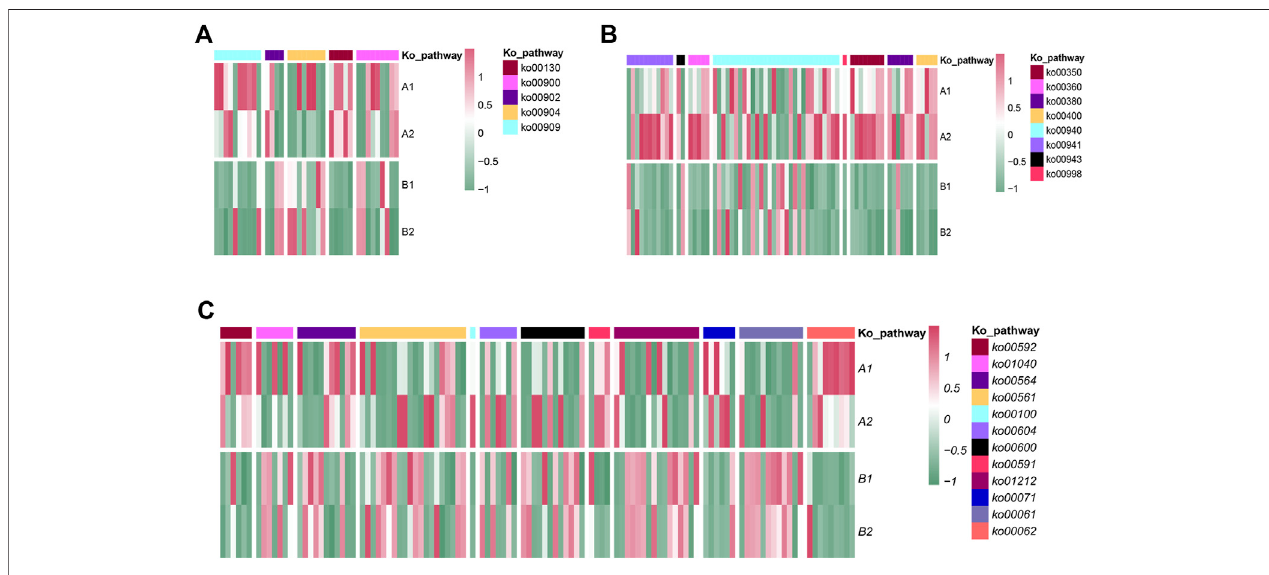
FIGURE 9 | Transcript expression analyses and the biosynthetic pathways of terpenoid metabolites (A) , active metabolites (B) and lipids (C) .